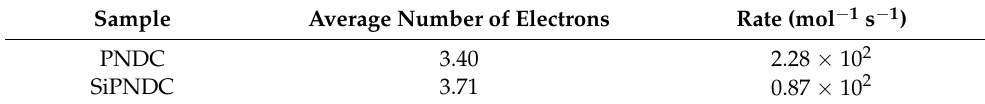
Table 5. Number of electrons and kinetic rate of oxygen reduction via PNDC and SiPNDC.